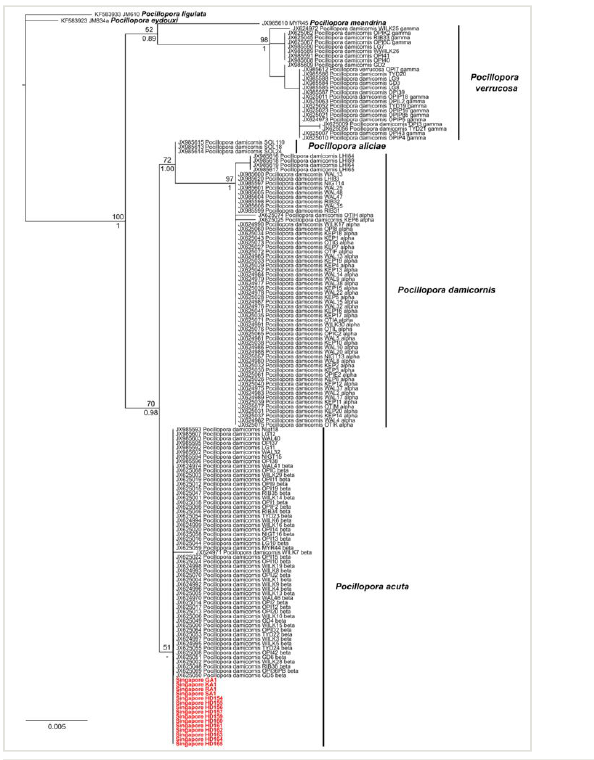
Maximum likelihood tree of seven Pocillopora species based on the mitochondrial open reading frame. Colonies from Singapore are shown in red. Bootstrap values ( ≥ 50) and Bayesian posterior probabilities ( ≥ 0.85) are shown for supported